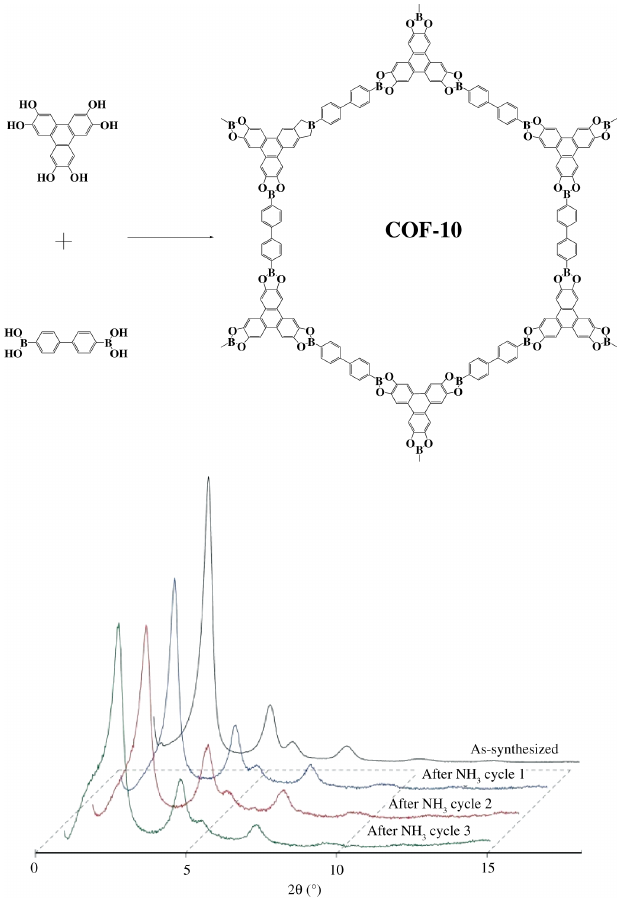
Figure 8: Synthesis process and XRD patterns after adsorbing NH for different cycles of COF-10. 3 The crystallinity of COFs is a distinctive feature as compared to other porous organic materials; single-crystal X-ray diffraction (SXRD) and rotating electron diffraction are also applied to the